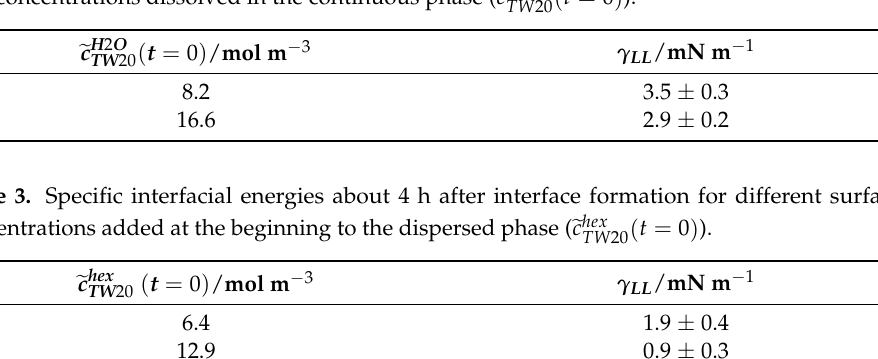
Table 2. Specific interfacial energies approximately 4 h after interface formation for different surfac- tant concentrations dissolved in the continuous phase ( (cid:101) c H 2 O